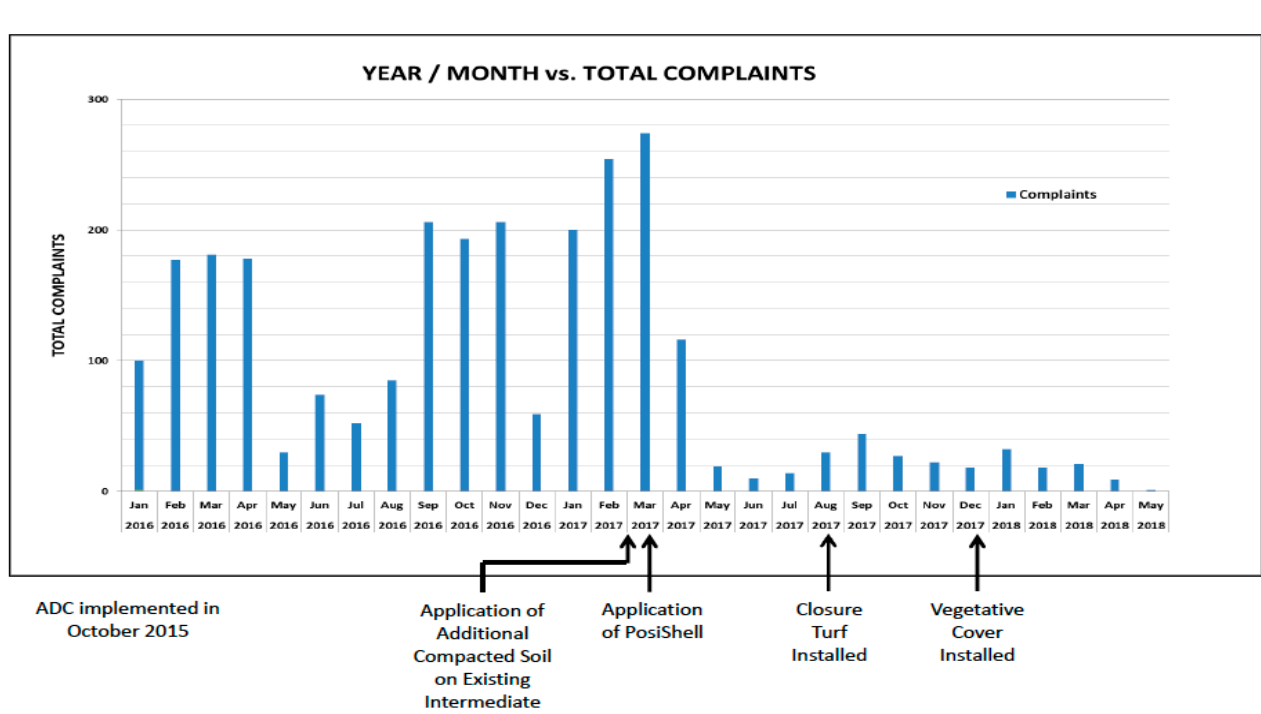
Figure 10. The Intermediate Cover Enhancement (ICE) timeline at the landfill [1]. The “Odor Patrol” study was from 30 October 2017 to 2 May 2018 (100 weekdays) when the Closure Turf and Vegetative Covers were installed and the total complaints dropped significantly.